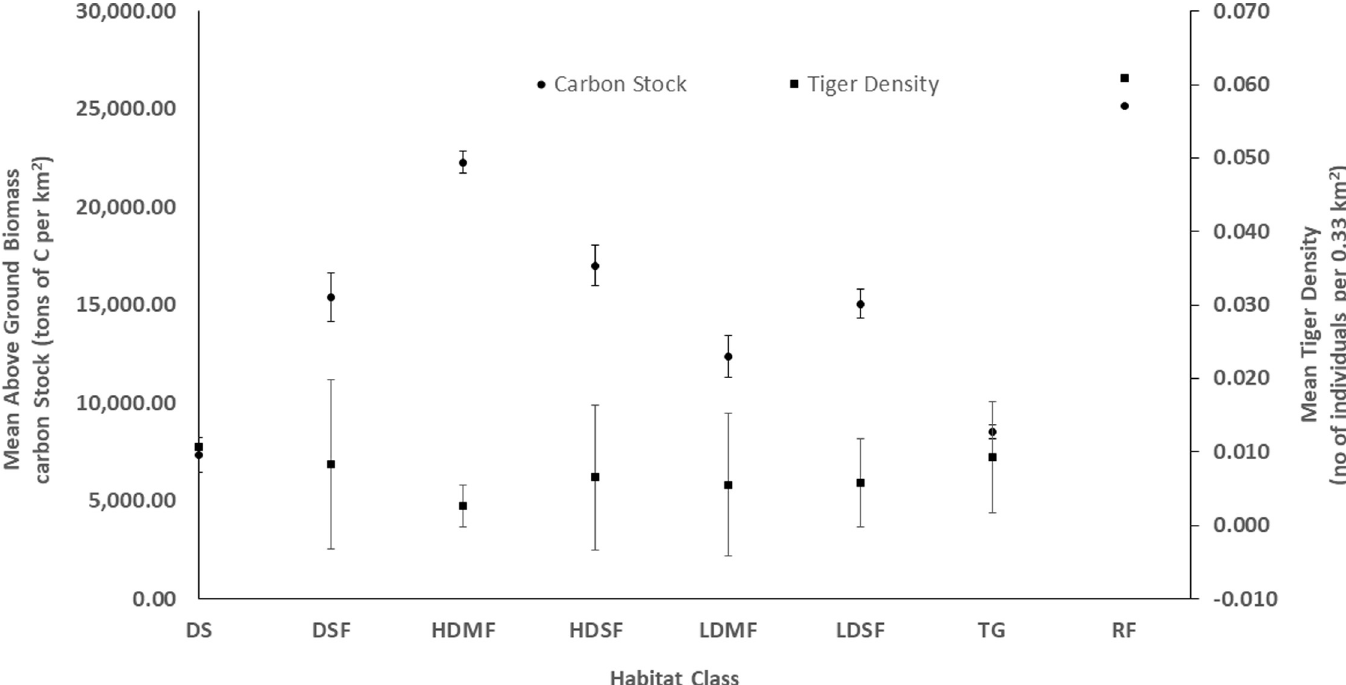
Fig 2. Variation in mean tiger density (no of individuals per 0.33 km 2 ) and above-ground biomass carbon stock (tons of carbon per km 2 ) along with standard error bars categorized by eight habitat categories. DS: degraded scrub; DSF: dry sal forest; HDMF: high density mixed forest; HDSF: high density sal forest; LDMF: low density mixed forest; LDSF: low density sal forest; TG: tall grassland; RF: riverine forest.